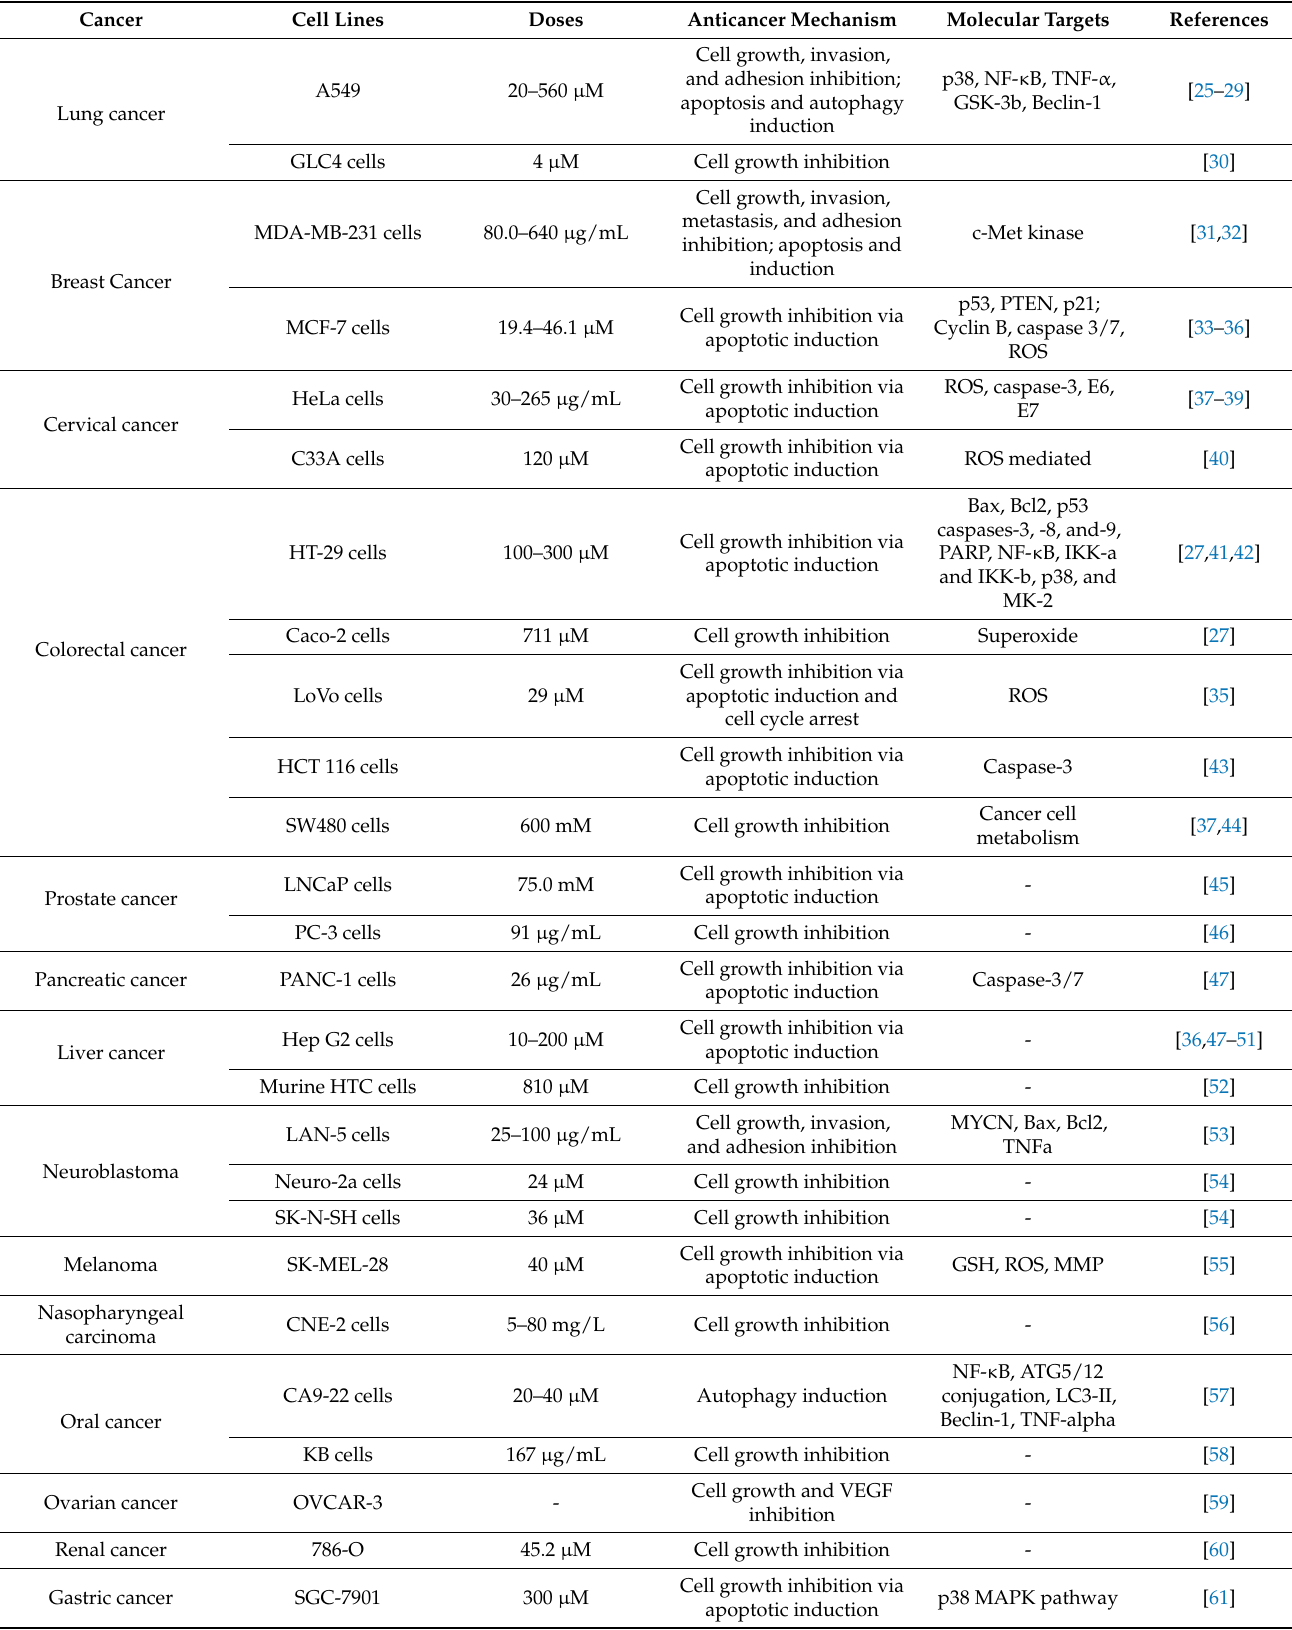
Table 1. In vitro antitumor efficacy of rutin and its mechanisms of